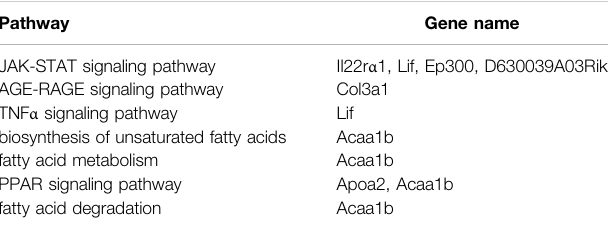
TABLE 1 | The pathways associated with signi fi cant differences in glucose and lipid metabolism in the KEGG enrichment.